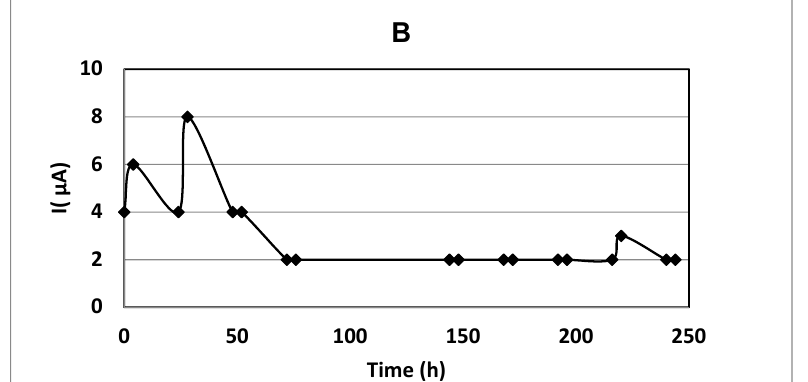
Figure 6. Experiment with immobilized cells with a constant electric field at anode potential 1.0 V/S.H.E. Initial phenol concentration 0.06 g dm −3 : ( A ) time profiles for added phenol and phenol concentration; ( B ) the electric current in immobilized cell culture.